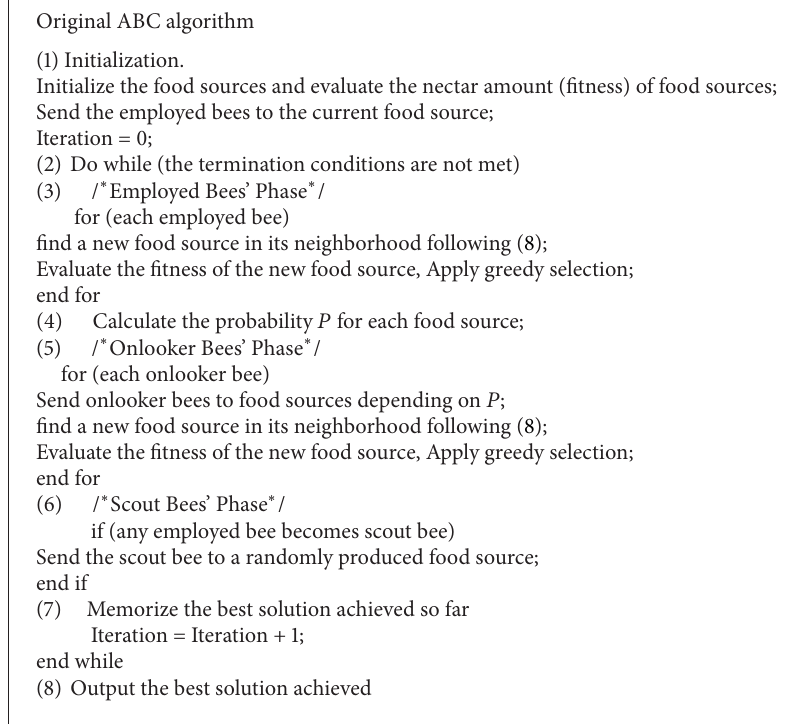
Algorithm 1: Pseudocode of the original ABC